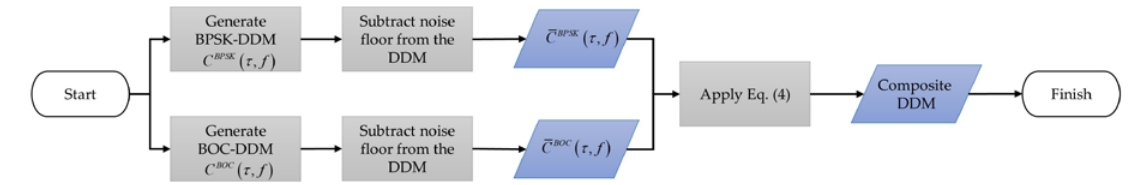
Figure 3. Flow chart of generating composite delay-Doppler map (DDM).